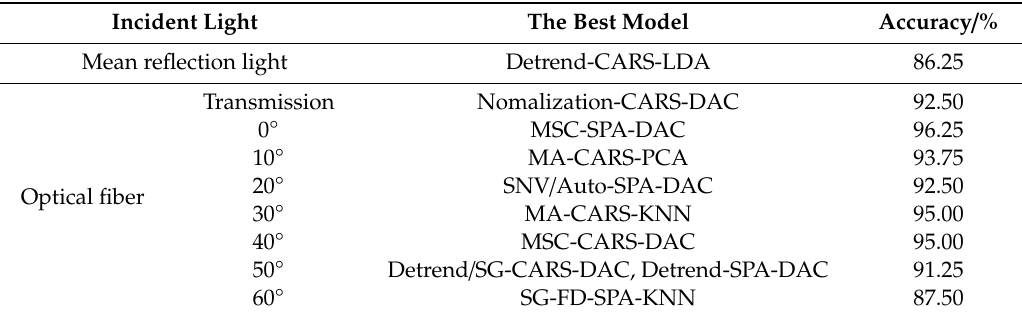
Table 8. The highest accuracy of a model under different incident lights.